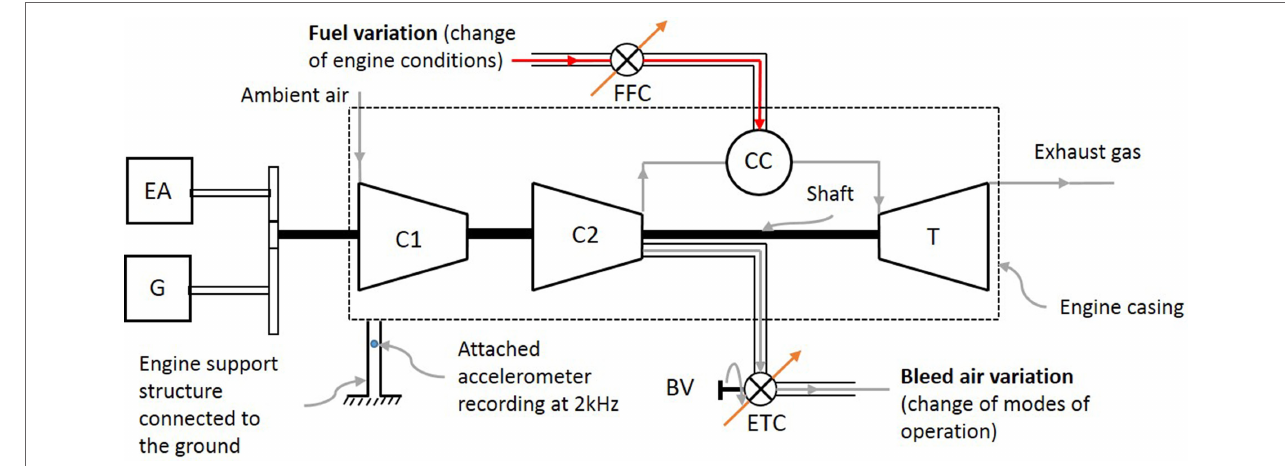
FIGURE 1 | Gas turbine engine schematic diagram of the experimental unit, depicting salient features.